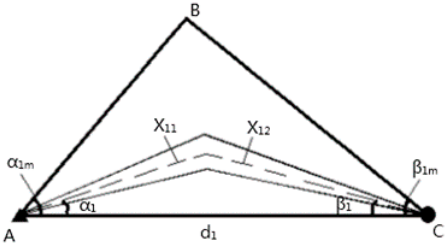
Figure 7. Sketch of a stream tube.